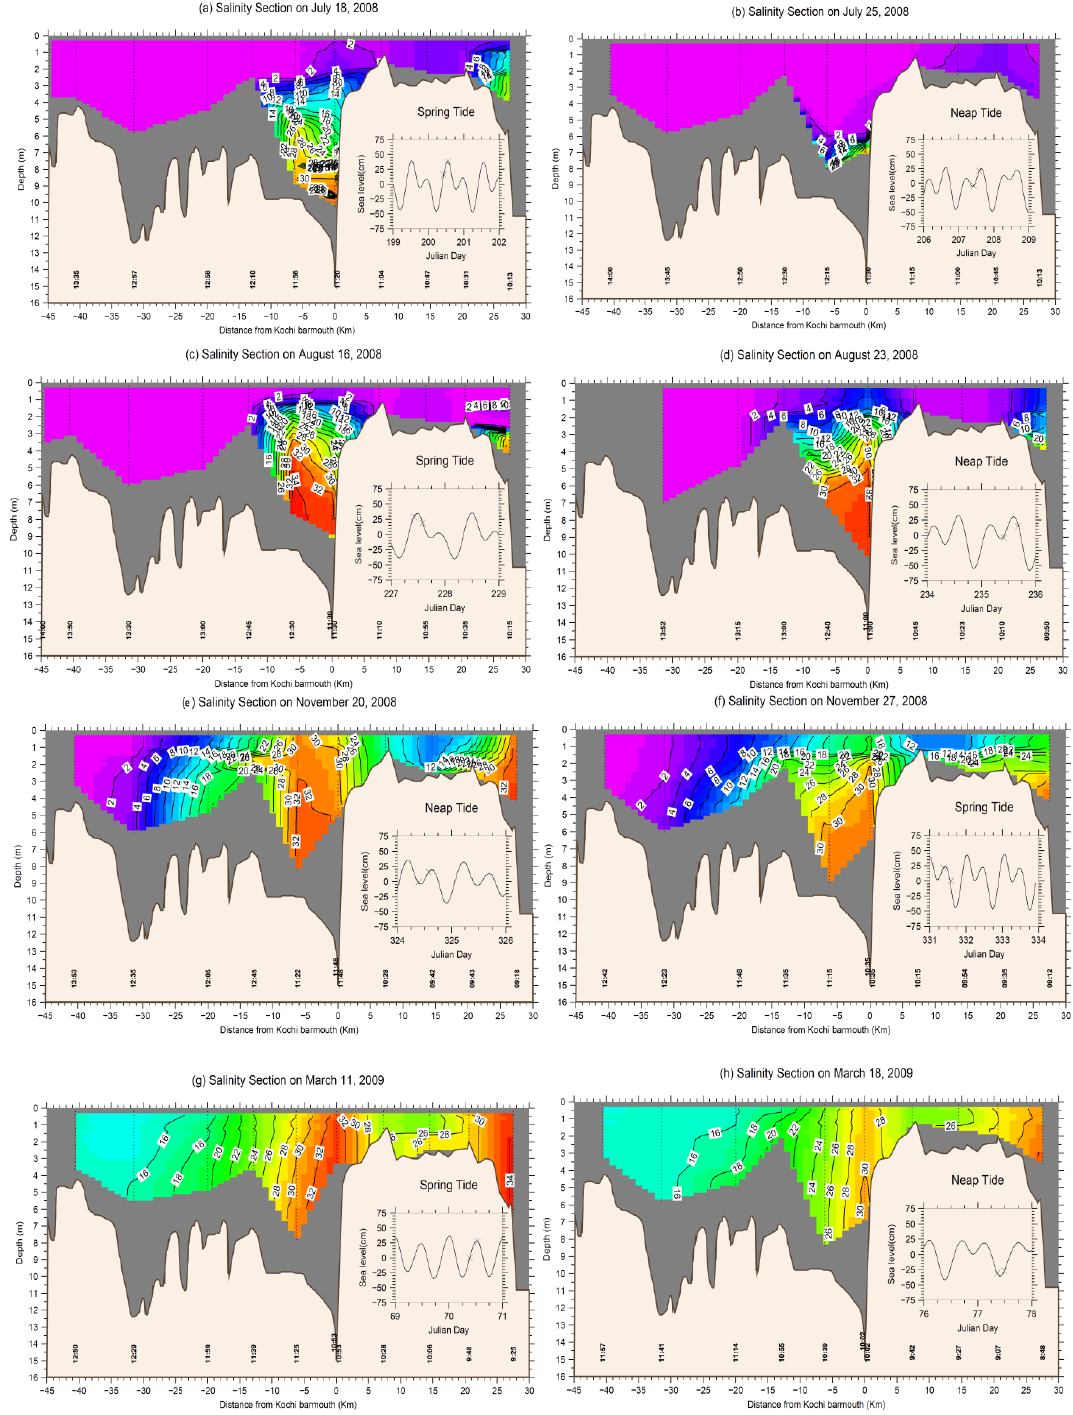
Fig. 8. Longitudinal synoptic distribution of salinity measured twice monthly (during spring and neap tides) During July 2008, August 2008, November 2008 and March 2009. The Cochin inlet is at the coordinate origin. The northern/southern arm stations are at positive /negative distances, respectively. The insets show the tidal amplitude and the times (as X’s) when each survey began and ended. Times of each station appear along the lower